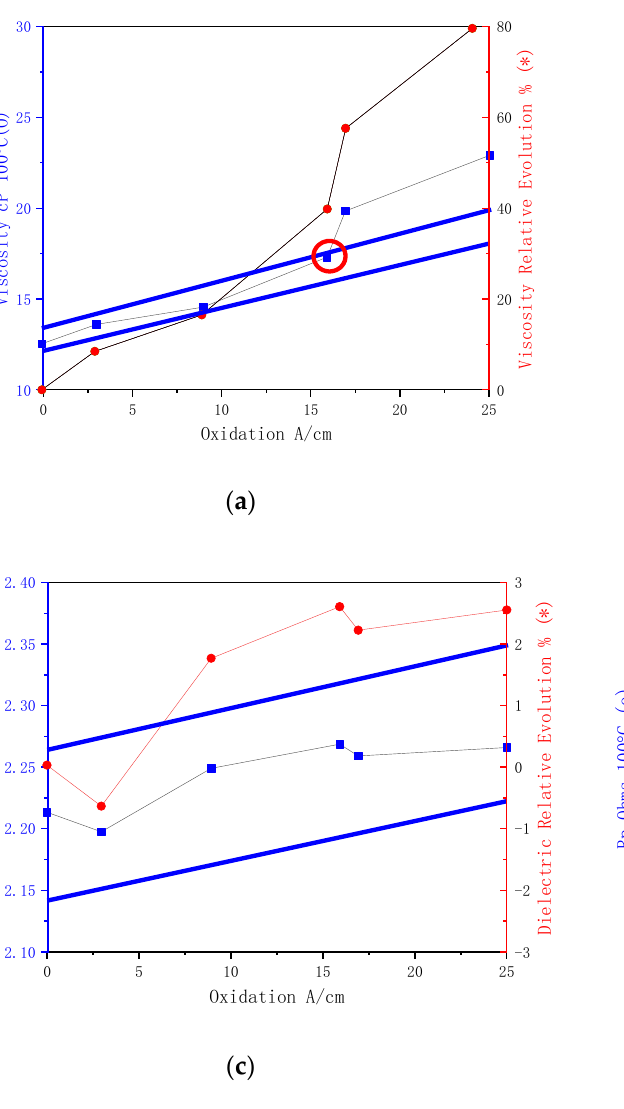
Figure 9. Engine oil (15W40) oxidation at 100 °C: ( a ) viscosity; ( b ) density; ( c ) dielectric; and ( d ) Rp. The models are plotted in Figure 9 with the related accuracy specifications given with full blue lines. The red circles represent detection of the entry into Phase 3 when η ≥ 1.05 η Rp ≥ 1.05Rp th .